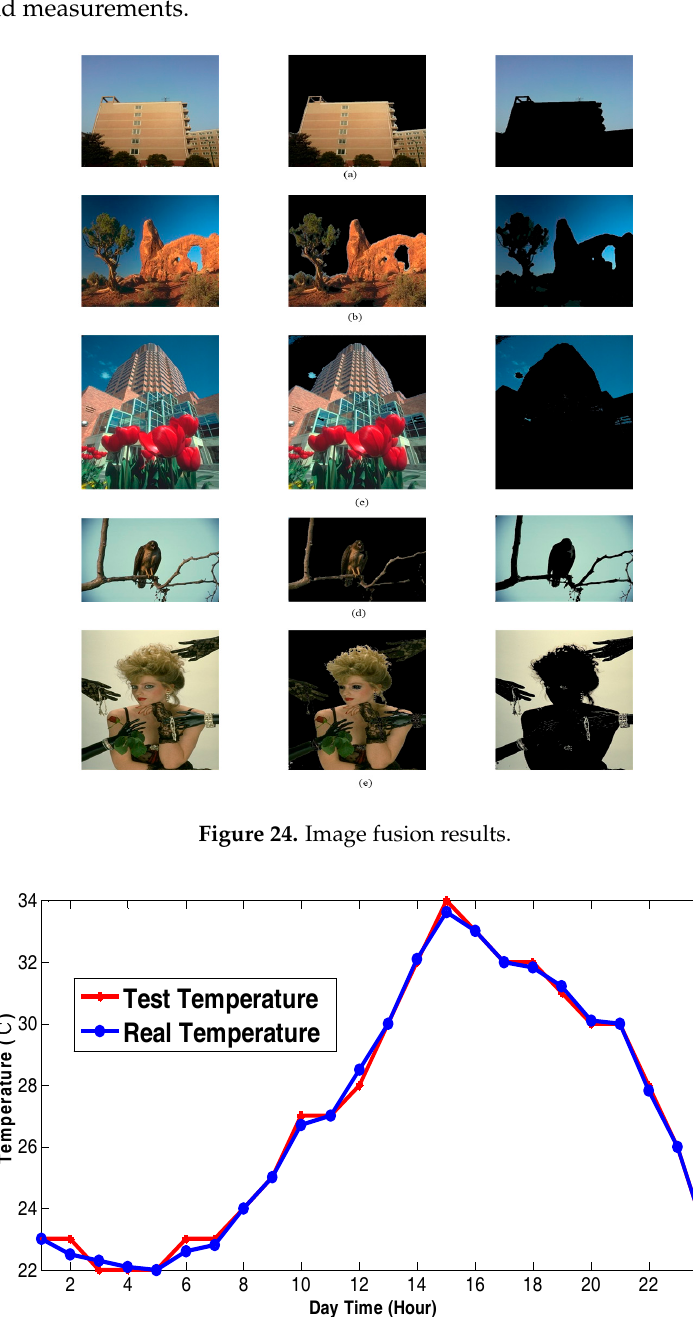
Figure 25. Real-time temperature changes on a sunny day.